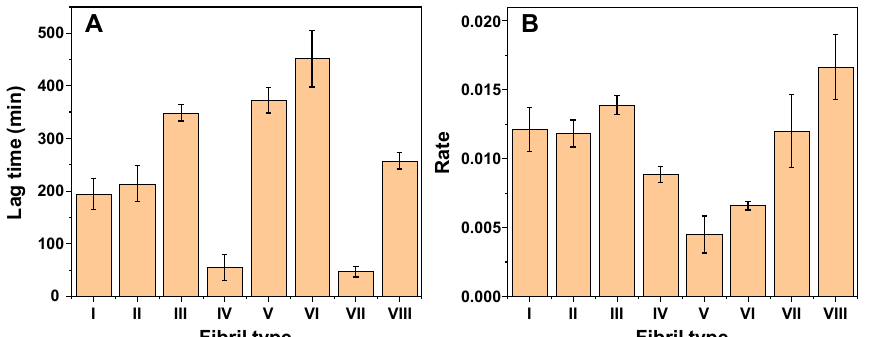
Figure A2. Boltzmann sigmoidal equation fit example with lag time (t lag ) and elongation rate calculation.